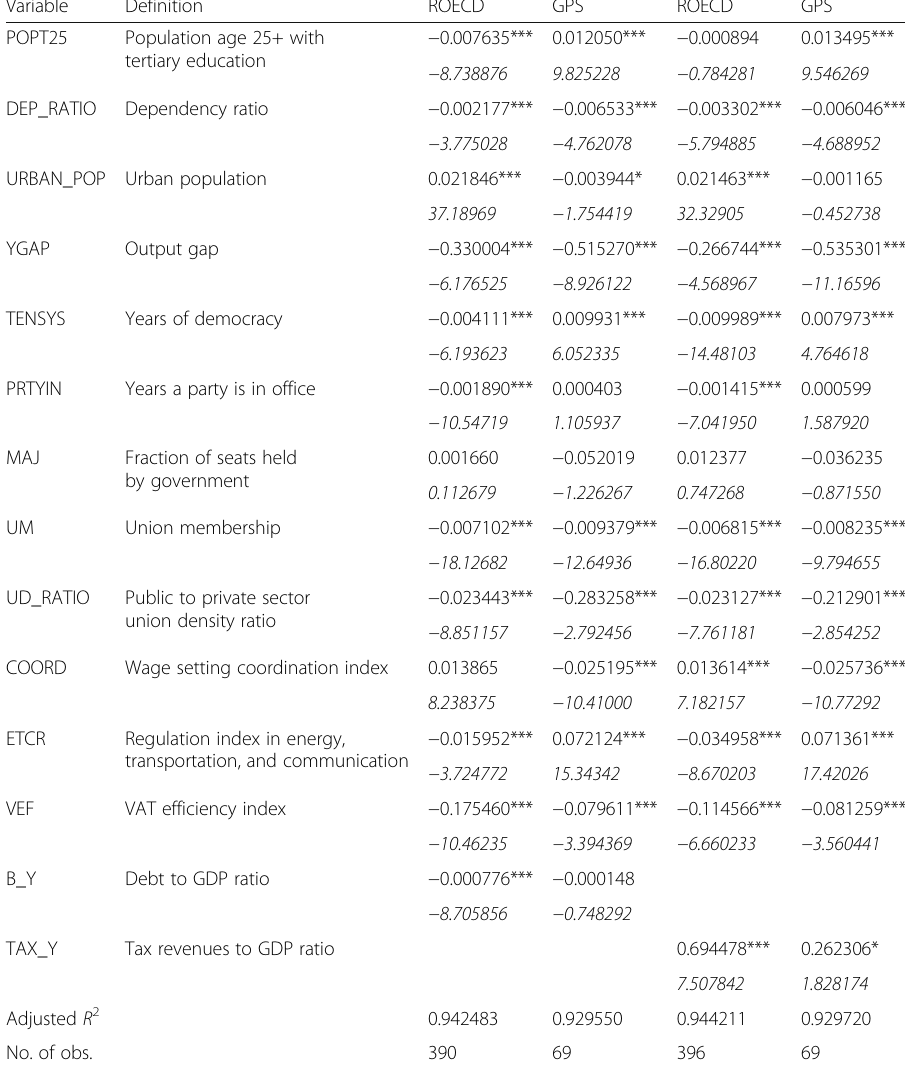
Table 8 A test of the IOS theory — dependent variable: TSL Variable